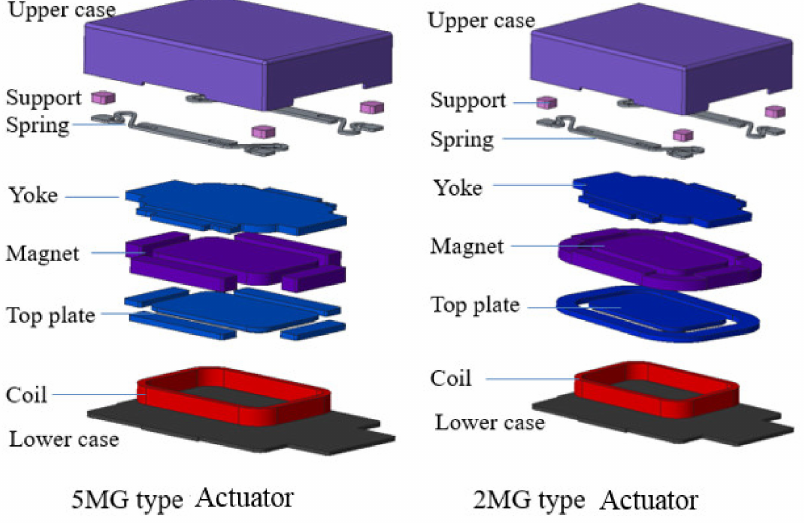
Figure 8. Structure of 5 MG and 2 MG type actuator.